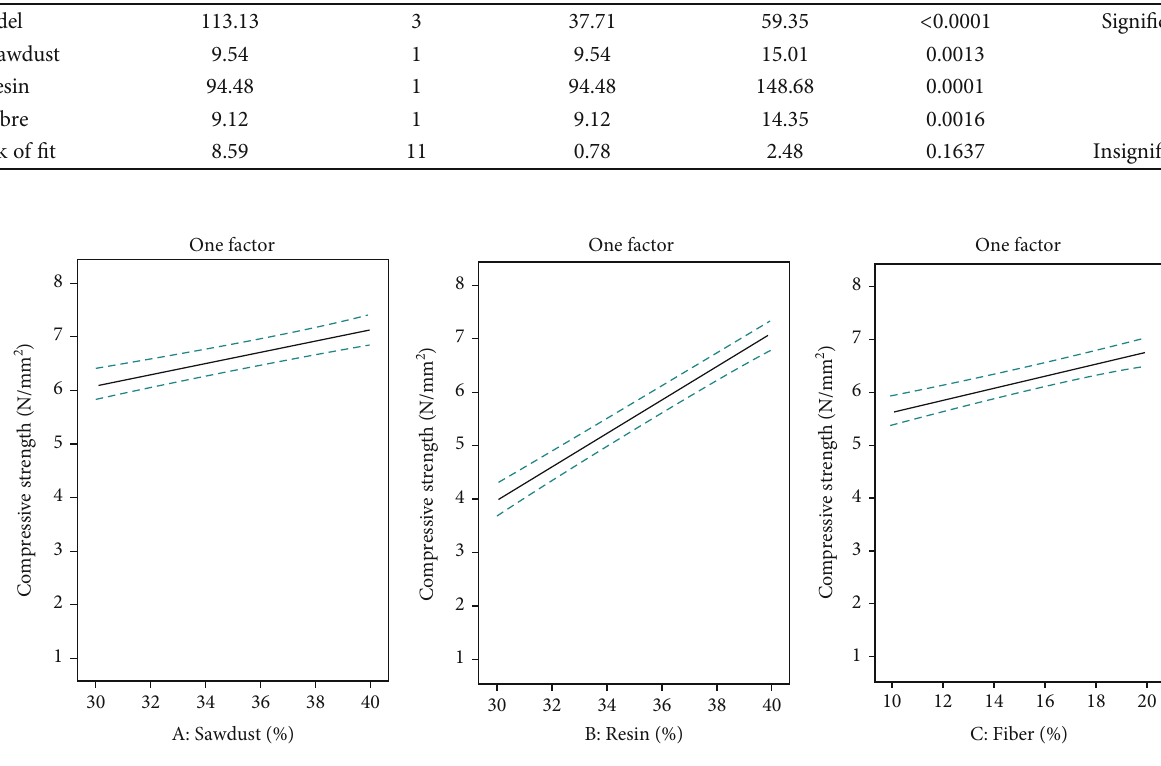
Figure 3: The e ff ect of factors on compressive strength.